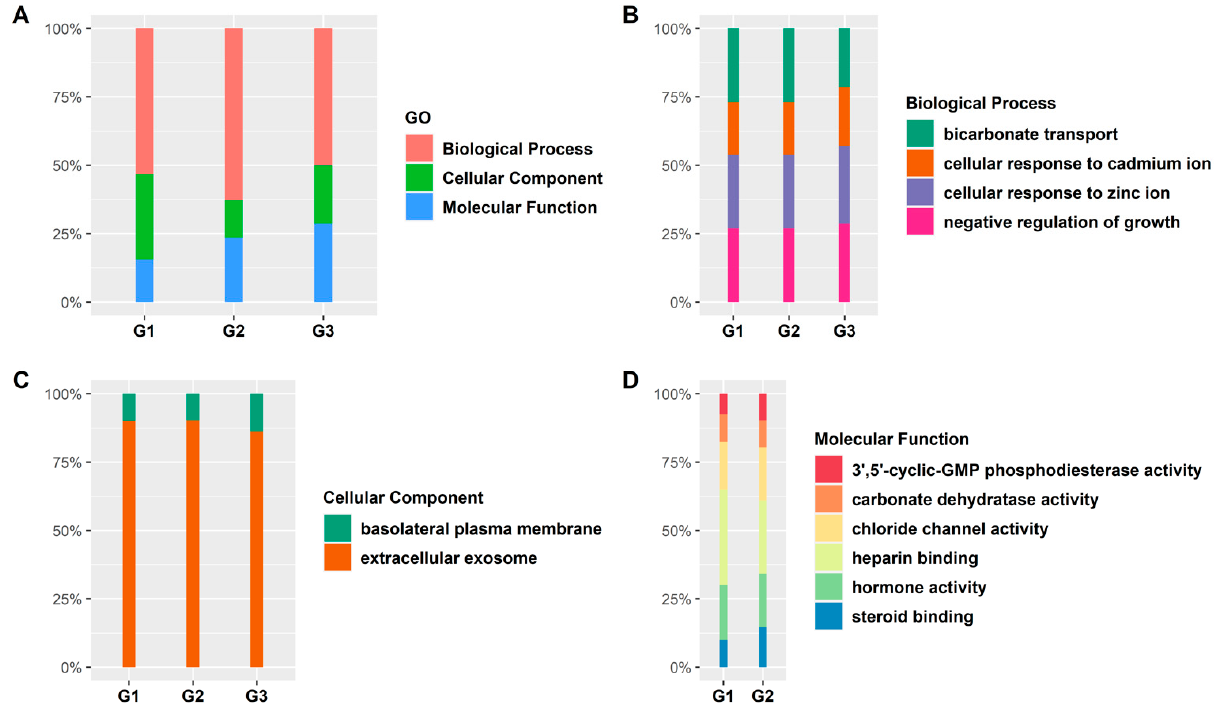
Figure 3. Functional group enrichment analysis of UR RRA genes in G1, G2, and G3. ( A ) Analyses of GO functional groups within G1, G2, and G3. The Y-axis of these 100% stacked columns shows the percentage of genes that fall within each GO functional group. ( B – D ) Common GO functionalities between all groups. ( B ) GO biological processes. ( C ) Molecular func- tions. ( D ) Cellular components.